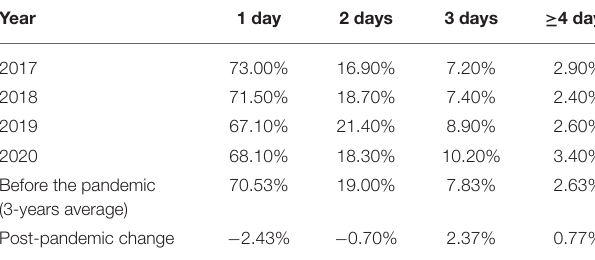
TABLE 3 | Days of